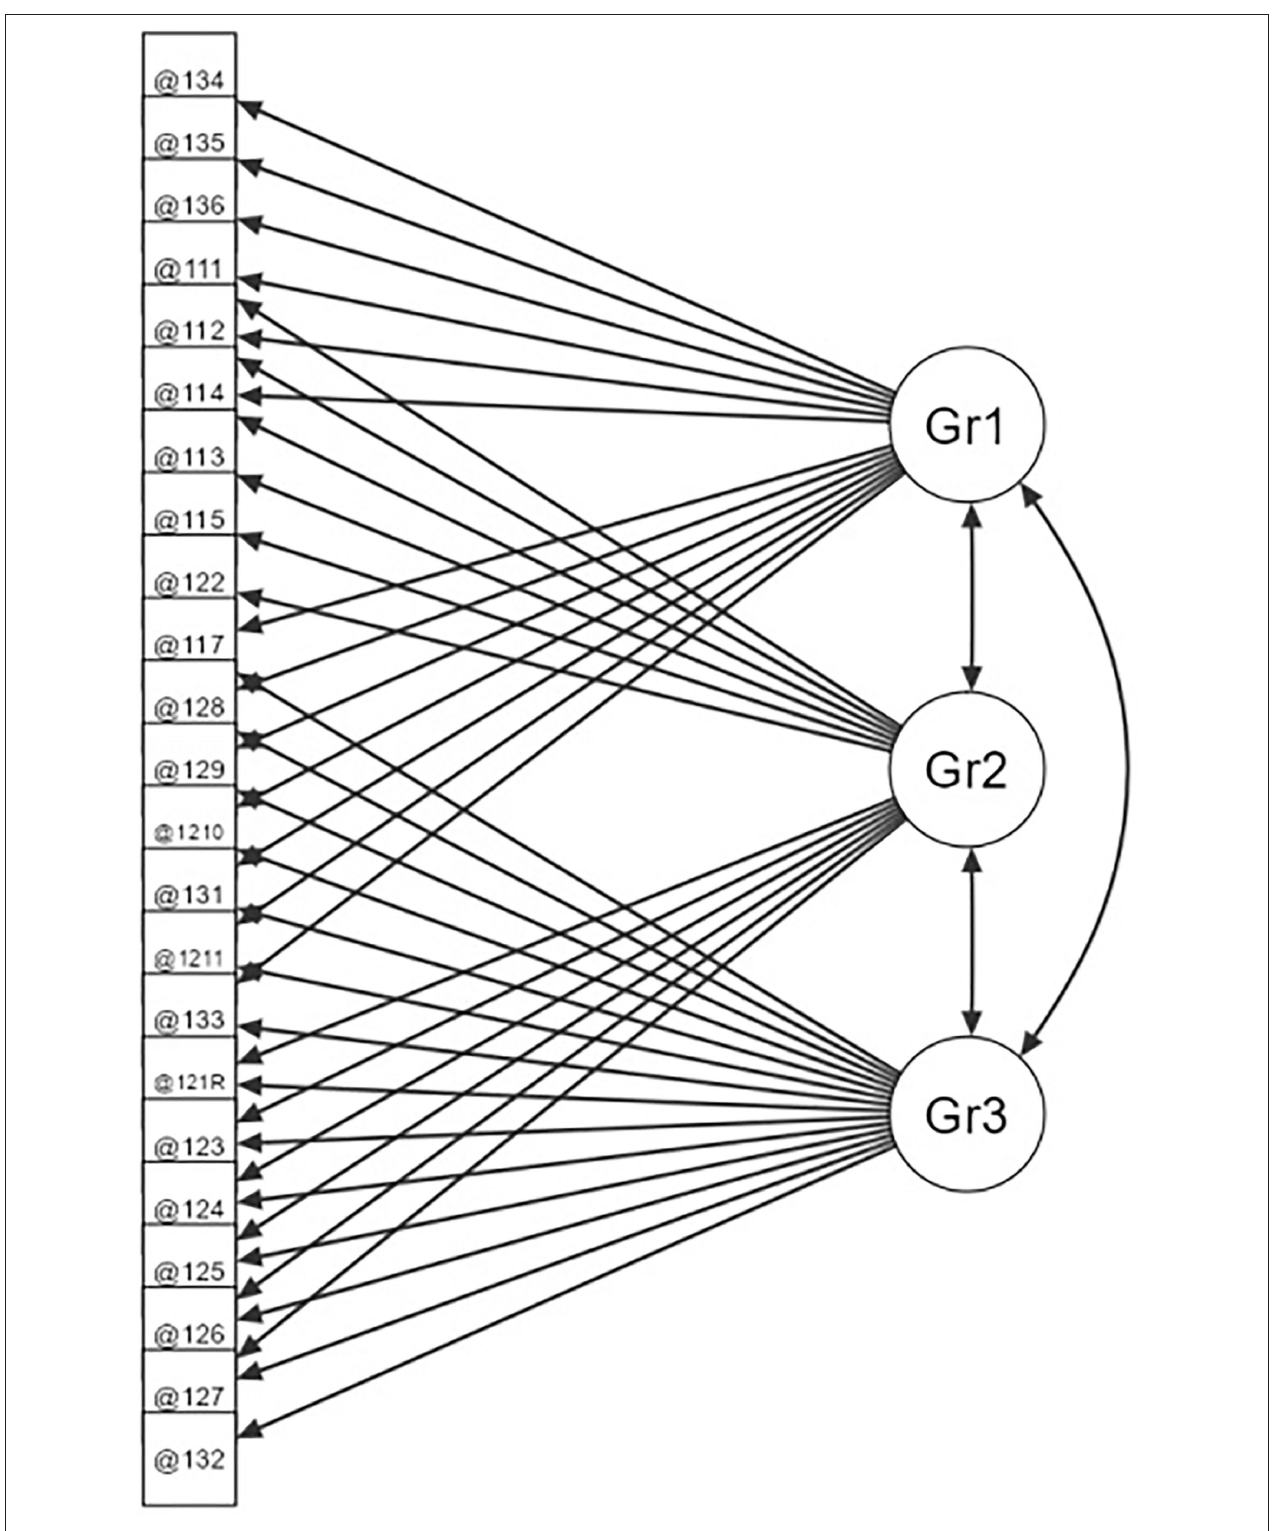
FIGURE 2 | Path diagrams and visual analysis of various